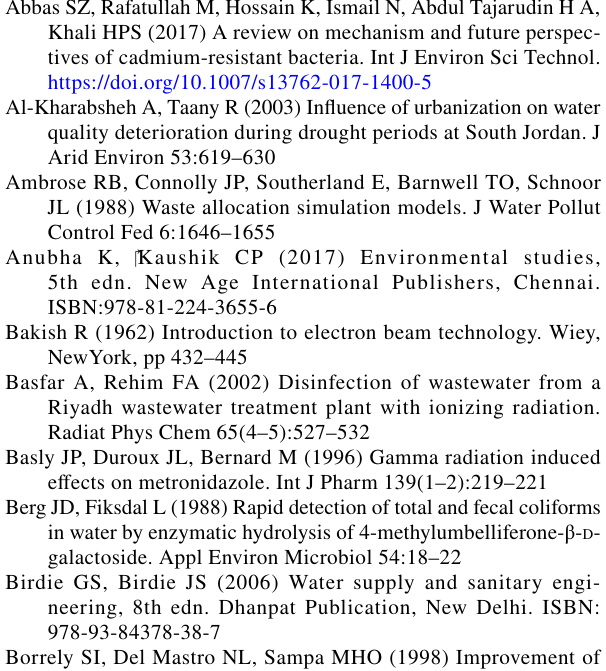
US $/m 3 total cost including operation, capacity and discharge water (Maruthi et